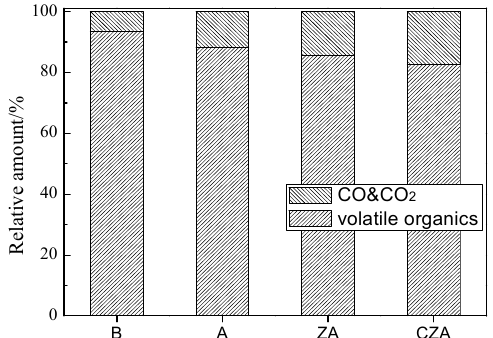
Figure 2. Relative content of CO and CO 2 and volatile organics by the effect of different catalysts.